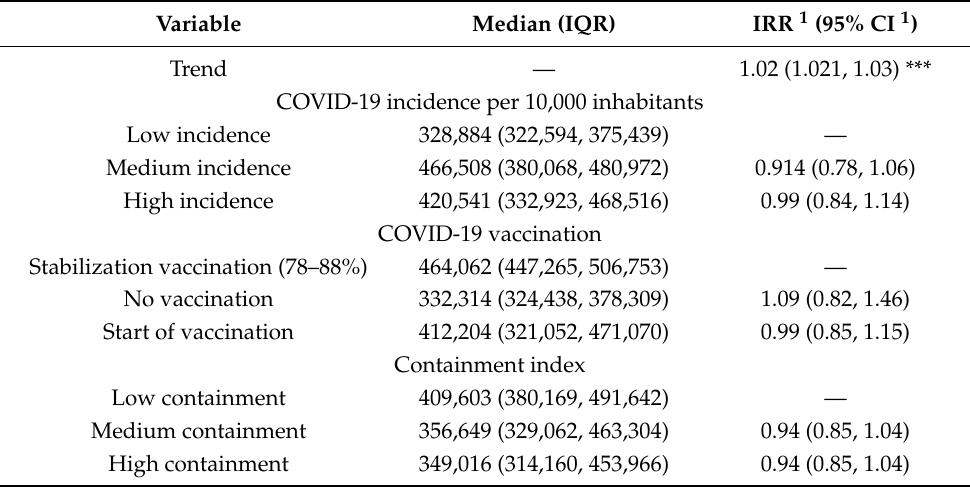
Table 3. ED visits for the variables and regression analysis for ED visits during the pandemic